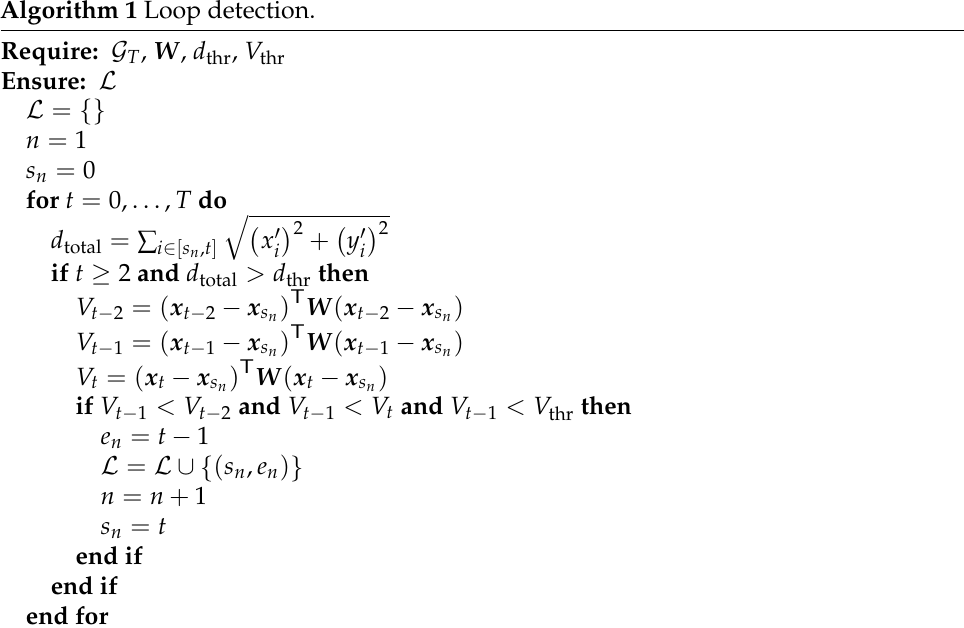
Algorithm 1 Loop